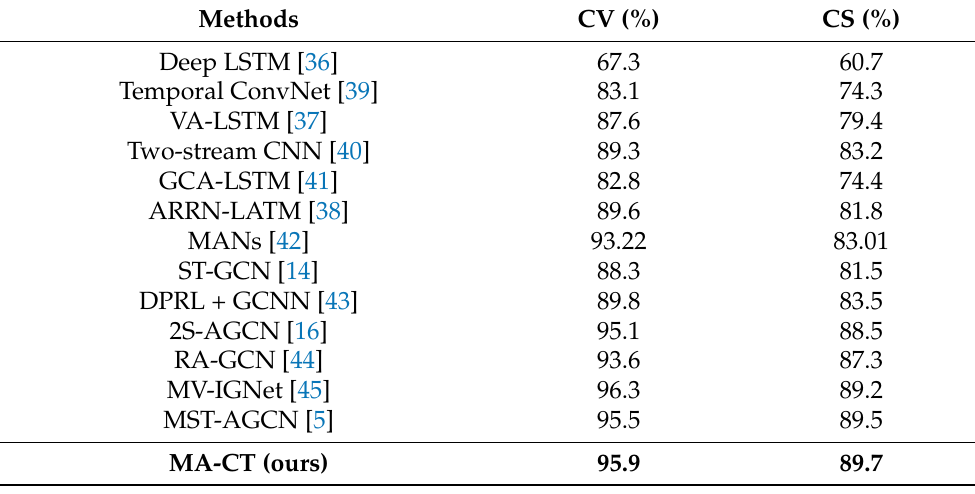
Table 3. Comparison of accuracy between ours model and other models on NTU-RGB + D dataset.